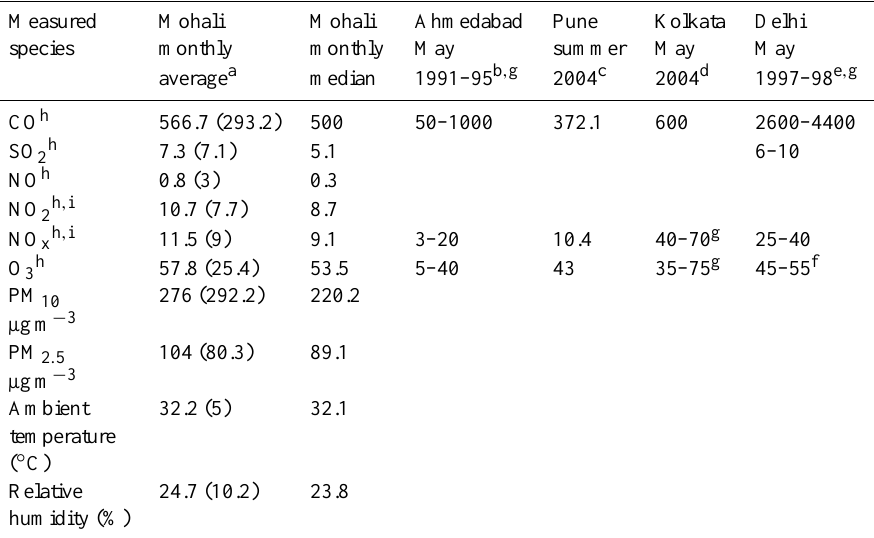
Table 4. Average, median and standard deviation of measured parameters at the air quality station at IISER Mohali in May 2012 and comparison with some previous works.